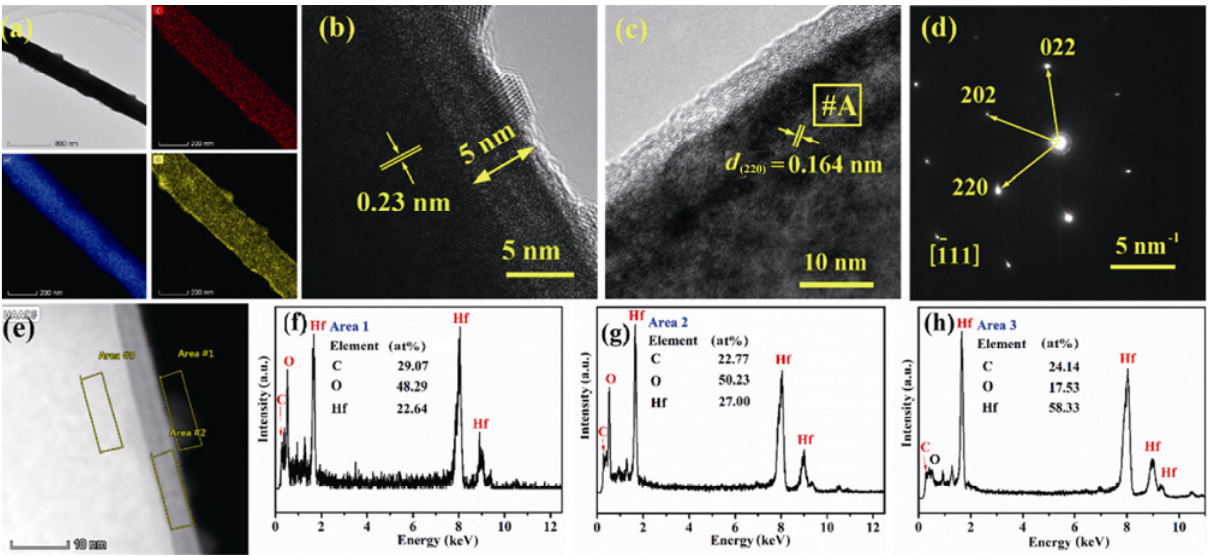
Fig. 3 Microstructures of HfC whiskers. (a) TEM image and EDS mappings of C, Hf, and O; (b, c) HRTEM images of edge region of the whiskers with and without nanoparticles, respectively; (d) SAED pattern of area #A in (c); and (e–h) high angle annular dark field (HAADF)–TEM image and corresponding EDS patterns of areas #1, #2, and #3. Note: d (220) is the spacing of the (220) lattice